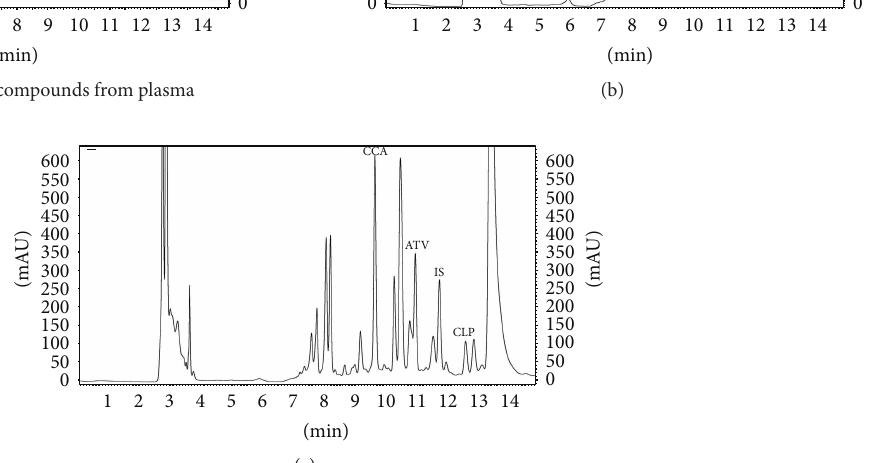
= 11.802 min), and clopidogrel bisulfate (CLP with 𝑅